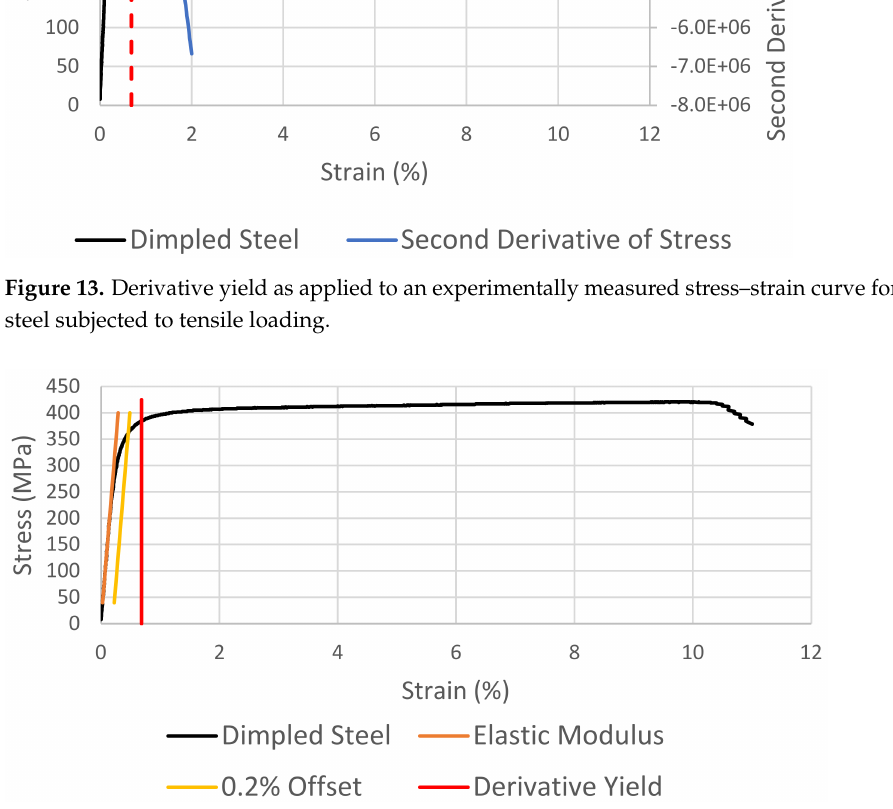
Figure 14. Comparison of the results from the offset yield and the derivative yield as applied to an experimentally measured stress–strain curve for dimpled steel subjected to tensile